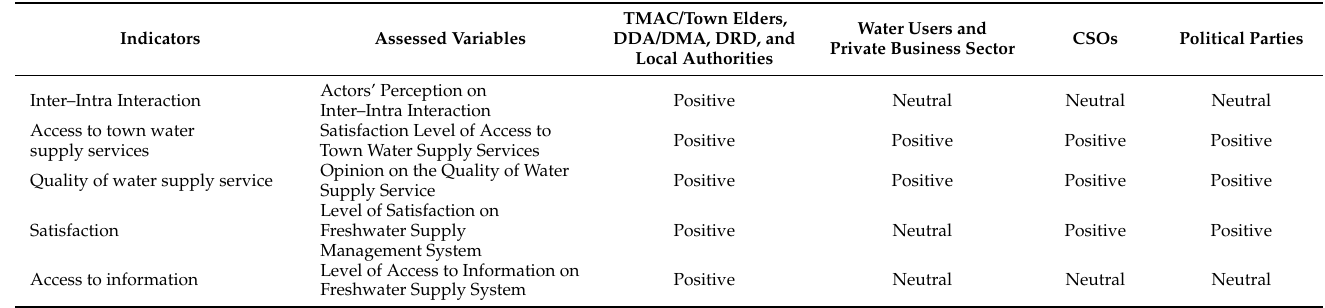
Table 5. Stakeholders’ Perception of Current State of Water Supply Governance in Rakhine